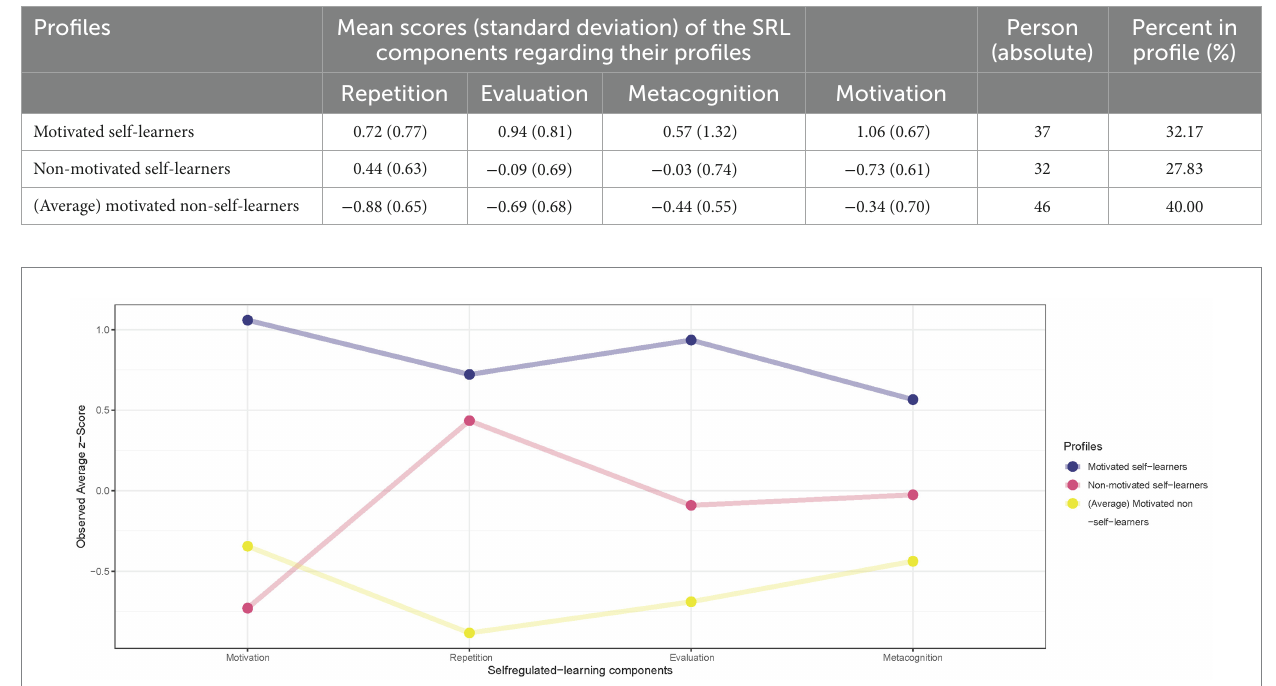
FIGURE 2 Observed average z -score for the three self-regulated learning (SRL) profiles: Motivated self-learners (blue), Non-motivated self-learners (red), and (Average) motivated non-self-learners